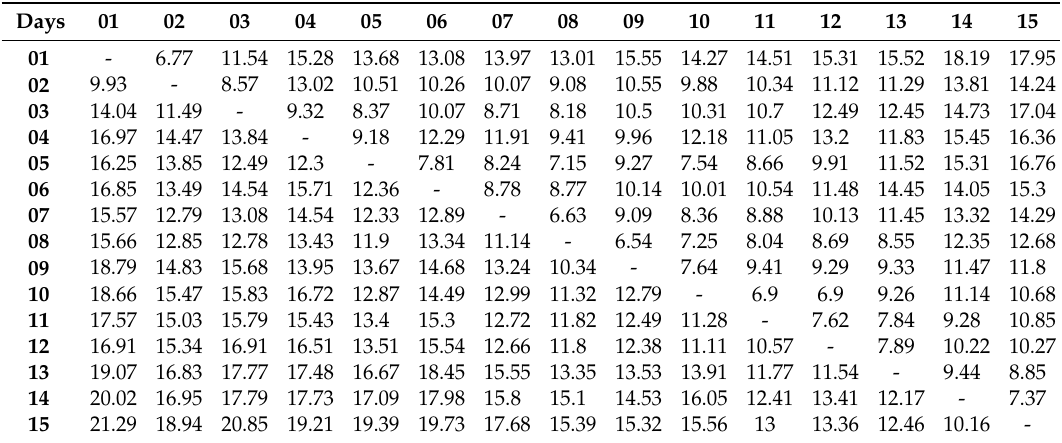
Table 2. SSAE-f vs LDA. Performance comparison using pairs of days. The upper diagonals show the CE with SSAE-f for the corresponding pair of day, while the lower diagonal is for